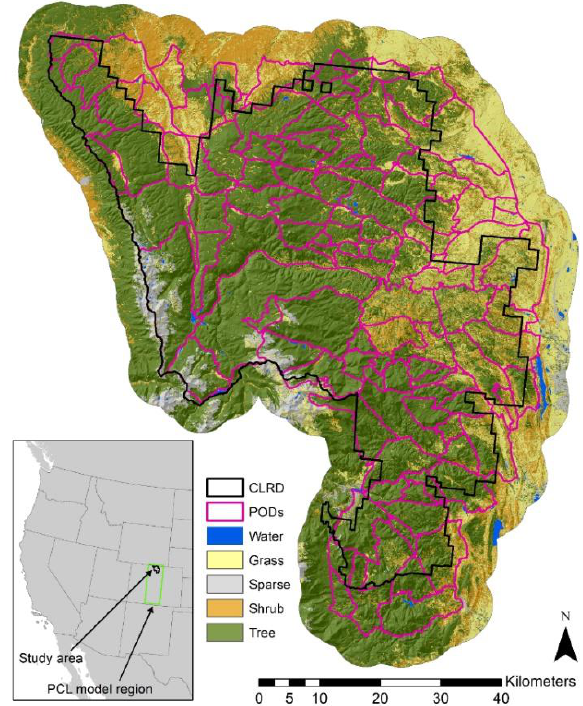
Figure 3. Map of potential wildland fire operational delineations (PODs) delineated for the Canyon Lakes Ranger District of the Arapaho-Roosevelt National Forest in Northern Colorado. The inset shows the location of the study area and potential control location (PCL) model region in the western United States. Land cover is from LANDFIRE [52]. Note that POD boundaries, by design, cross the administrative boundaries of the Ranger District. The spatial datum and projection are North America 1983 Albers Conic Equal Area for this and following figures.